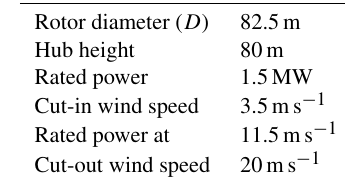
Table 1. Technical specifications of the turbines studied in the CWEX-13 field campaign (General Electric,